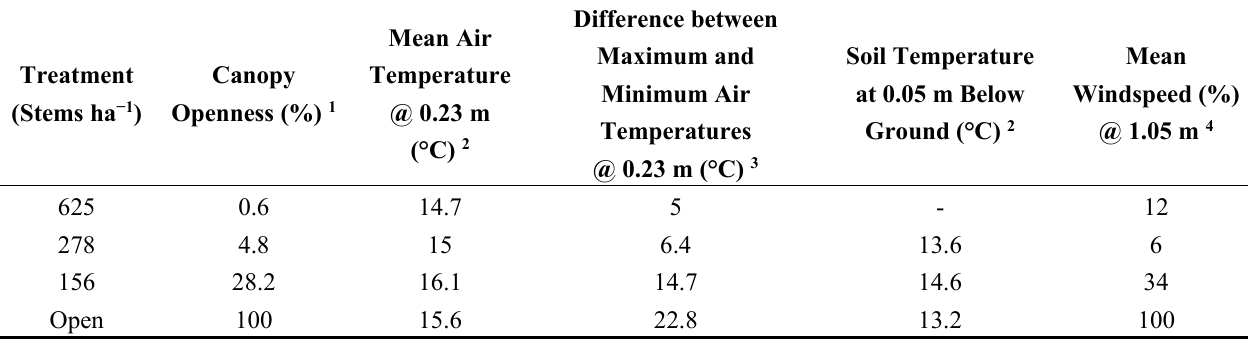
Table 3. Selected characteristics of the microclimate underneath a Sitka spruce stand in southern Scotland thinned to different densities (adapted from Sellars,